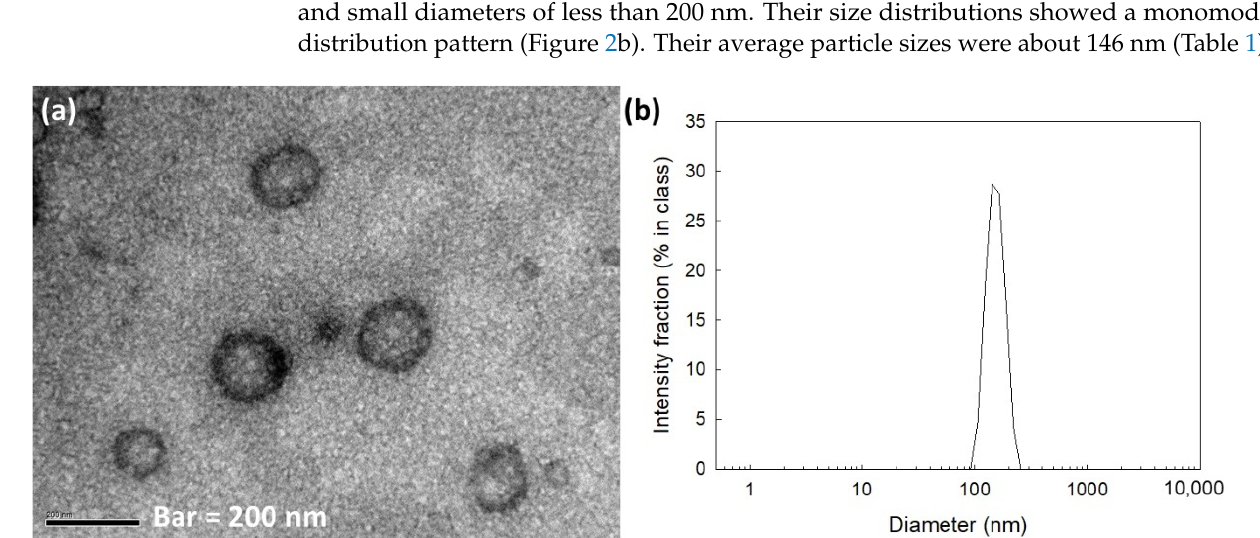
Table 1. Characterization of COSthPBAP nanophotosensitizers.